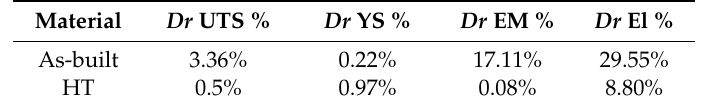
Table 4. Anisotropy of tensile strength, yield strength, elongation and elasticity modulus before and after heat treatment.